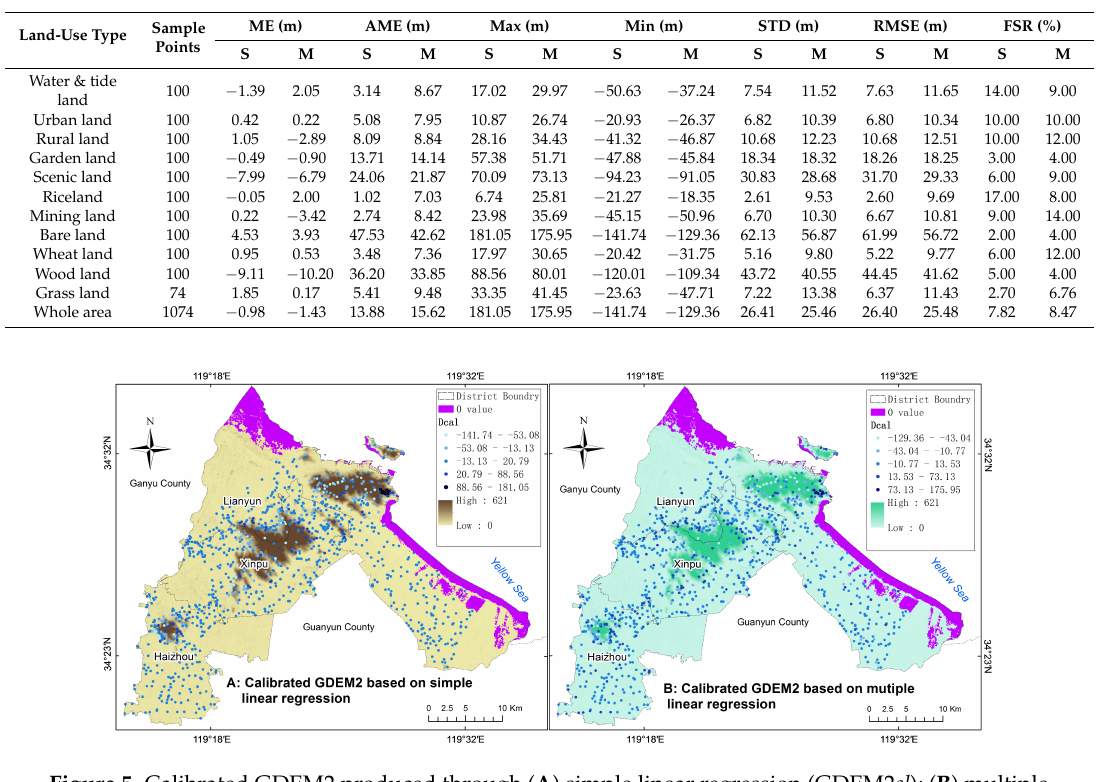
Figure 5. Calibrated GDEM2 produced through ( A ) simple linear regression (GDEM2 sl ); ( B ) multiple linear regression (GDEM2 ml ),